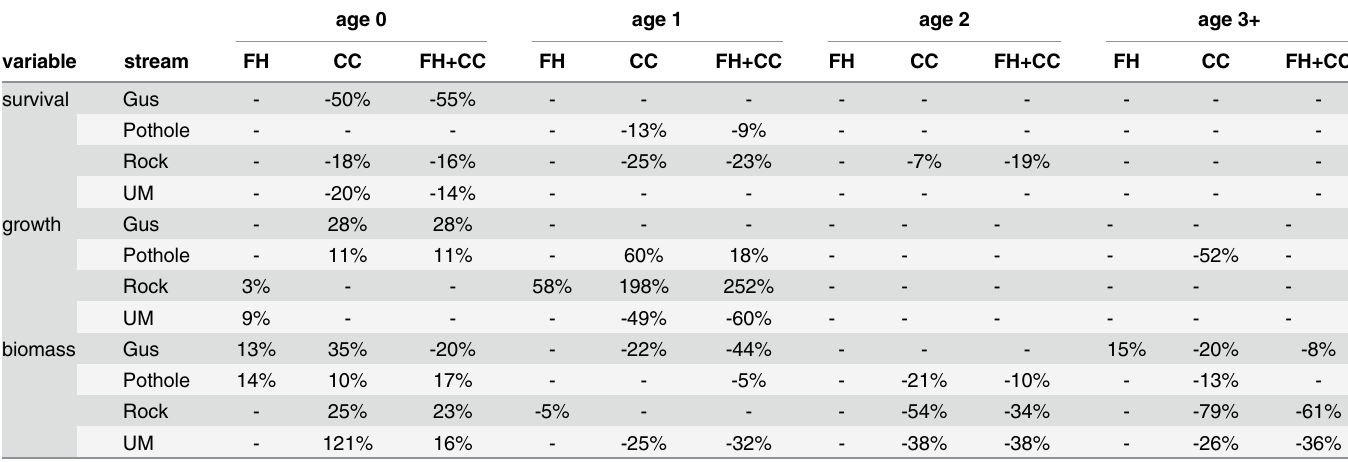
Table 1. Summer Survival, Growth, and Biomass by Age Class.